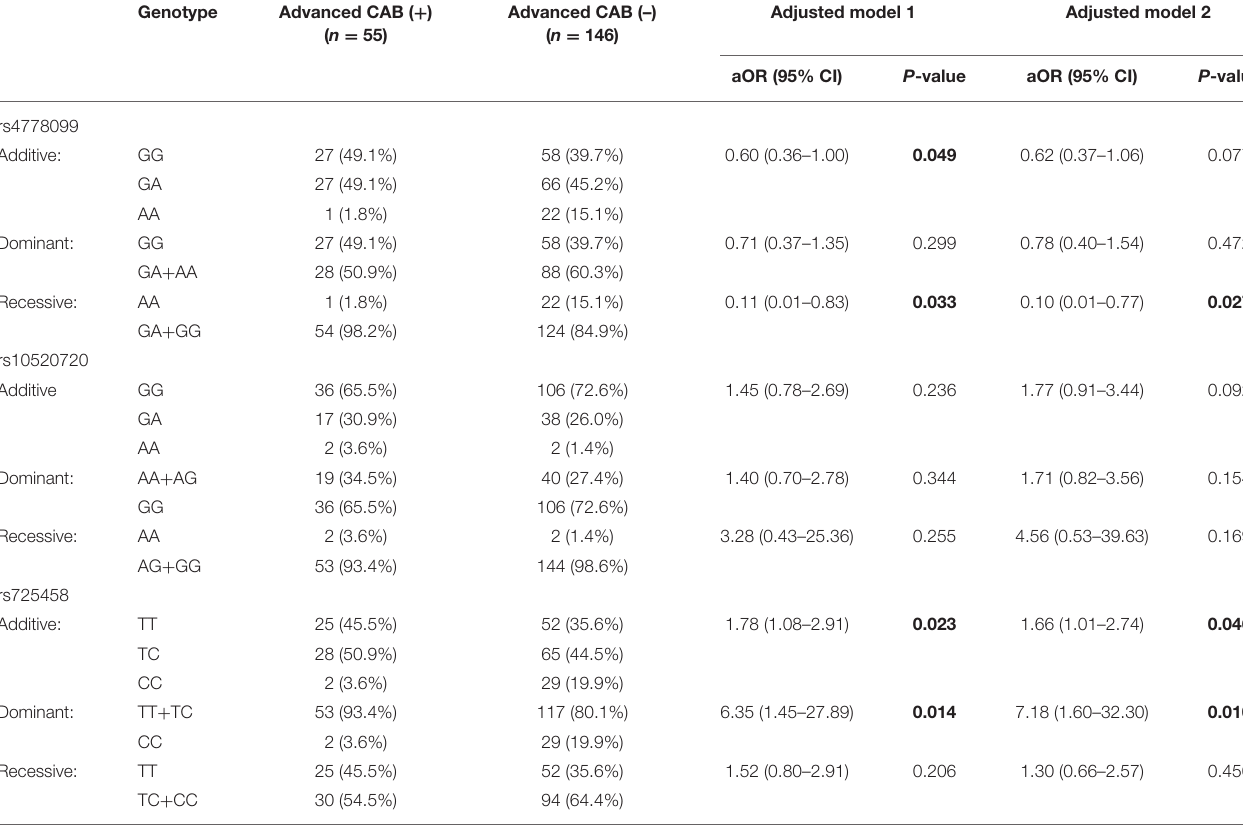
TABLE 3 | Association between predicted functional SNP in RGMA promoter and cerebral atherosclerosis burden adjusted for common vascular risk factors.